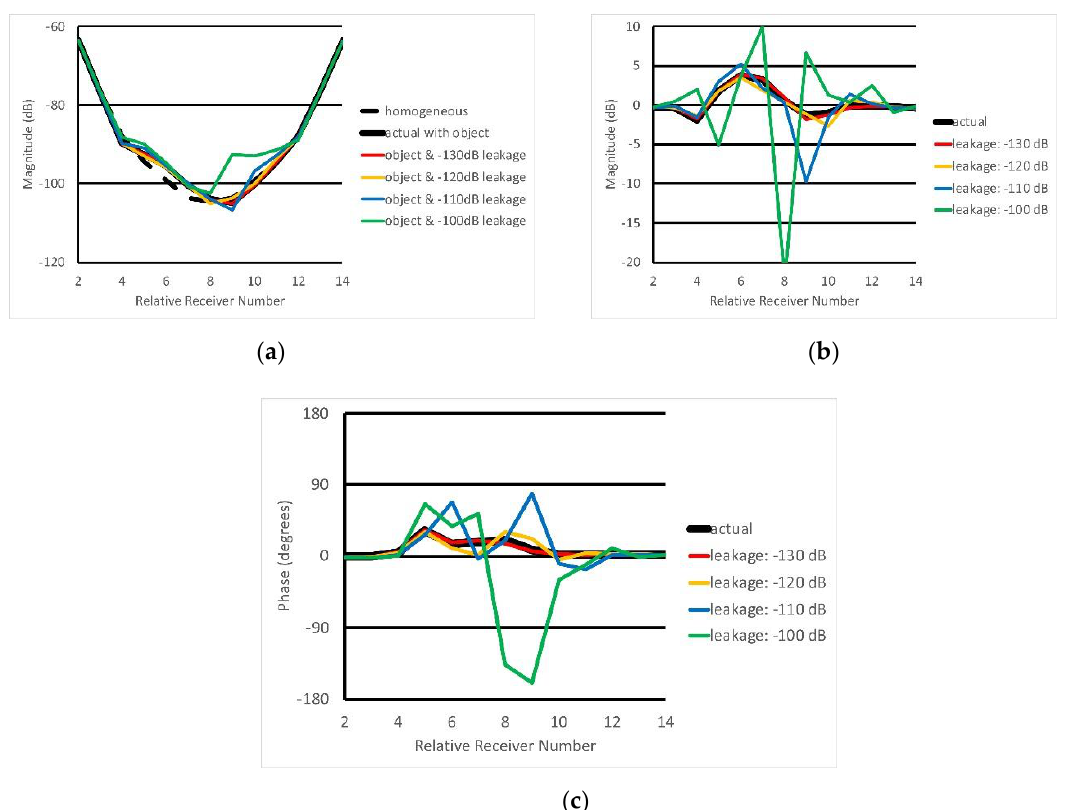
Figure 11. Plots of measurement data for antenna 1 transmission including cases with varying levels of added leakage signal: ( a ) raw magnitude, ( b ) calibrated magnitude, and ( c ) calibrated phases. The dashed black line represents the measured signal for the homogeneous bath whereas the solid black line indicates results when the object is present, respectively. Colored lines symbolize signals when the object is present but with progressively increasing leakage added.